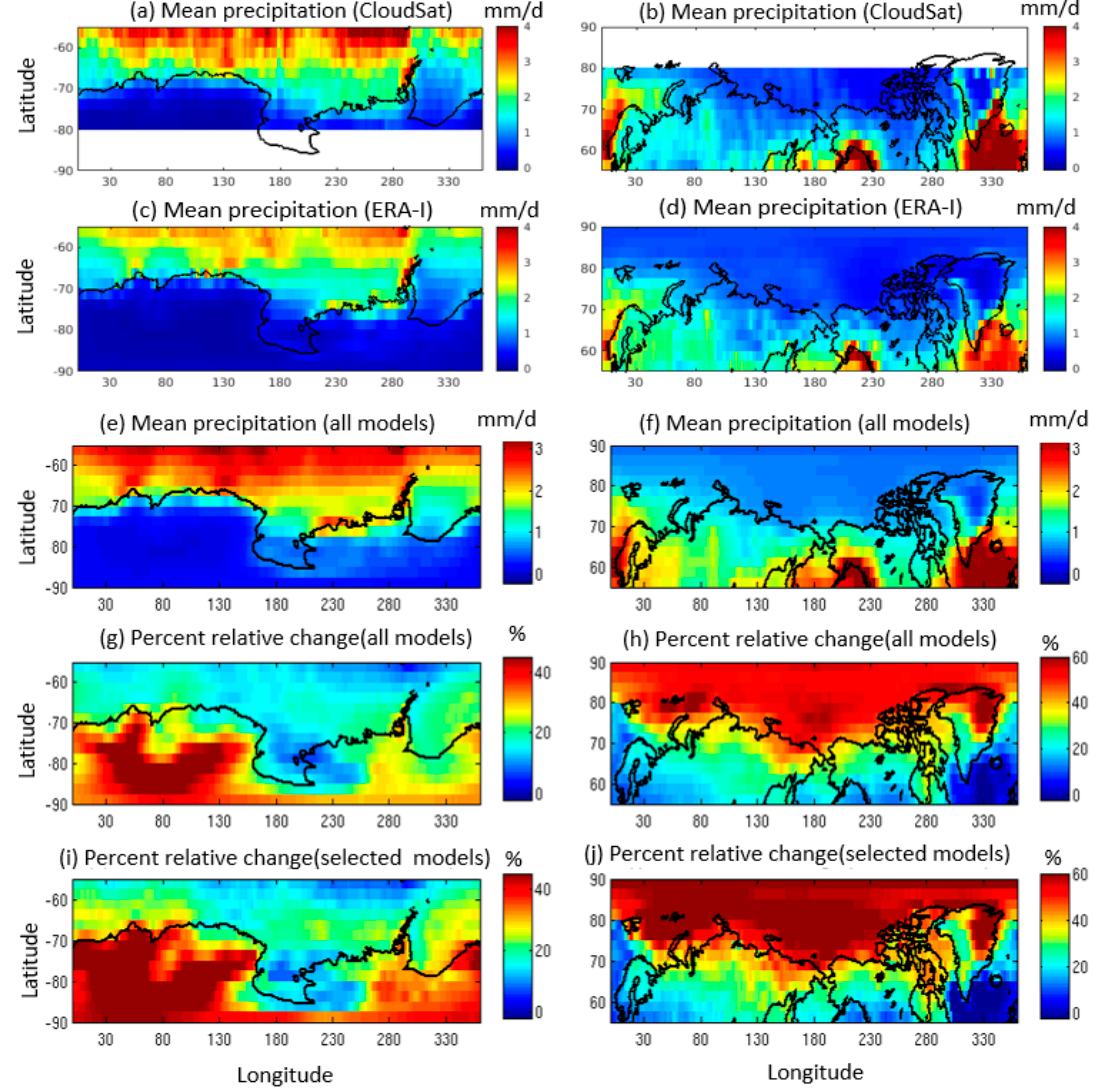
Figure 4. Maps of annual mean precipitation for 2007–2010 from CloudSat ( a , b ) and ERA-I ( c , d ). It also shows maps of all-model annual mean precipitation for 1976–2005 ( e , f ) and percent precipitation change (by comparing 1971–2100 with 1976–2005) for all-model ( g , h ) and the selected subset ( i , j ) of models in NH and SH. The areas near the North and South poles that are not covered by CloudSat maps are shown in white color.